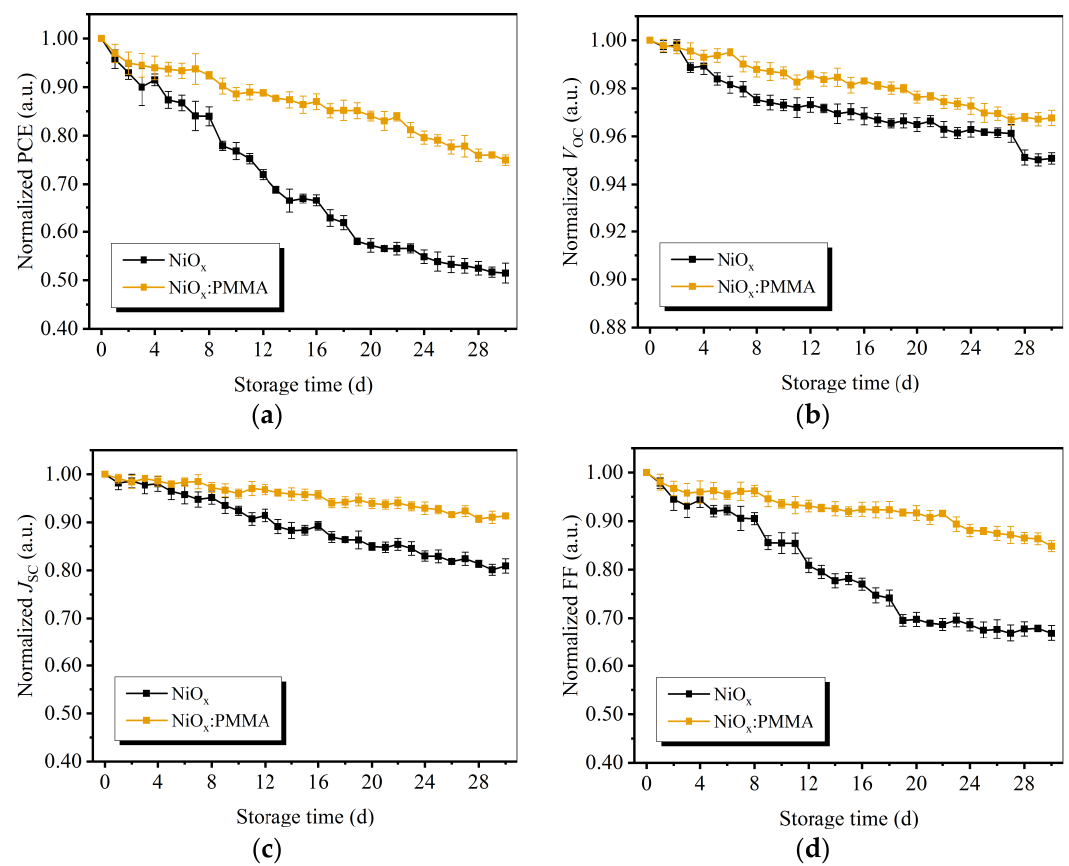
Figure 8. Normalized device performance parameters of OSCs after storing in ambient conditions for 30 d (statistical values obtained from 10 undoped or PMMA-doped devices fabricated in parallel): ( a ) PCE, ( b ) V OC , ( c ) J SC , and ( d )